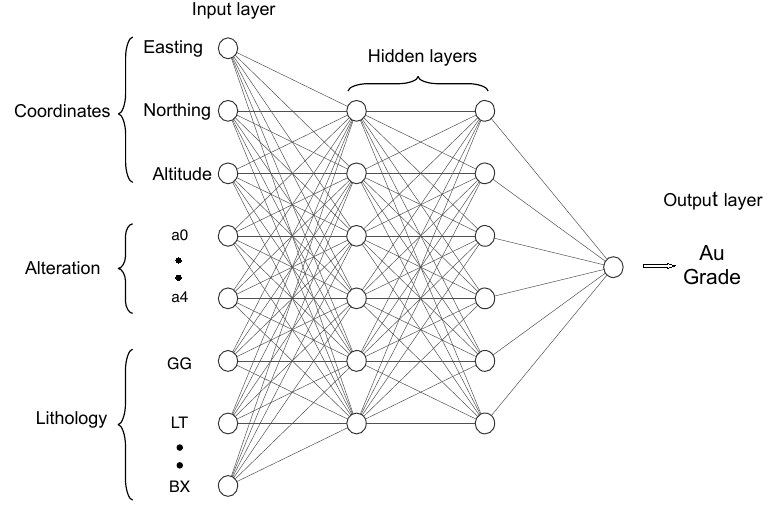
Figure 2. Proposed NN model